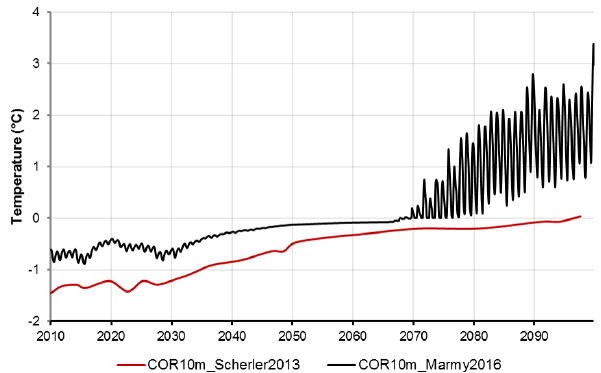
Figure 11. Comparison of the long-term simulation results for rock glacier Murtèl-Corvatsch at 10m depth for the present study and the results obtained by Scherler et al. (2013) with the same model, but with a different calibration (see text for